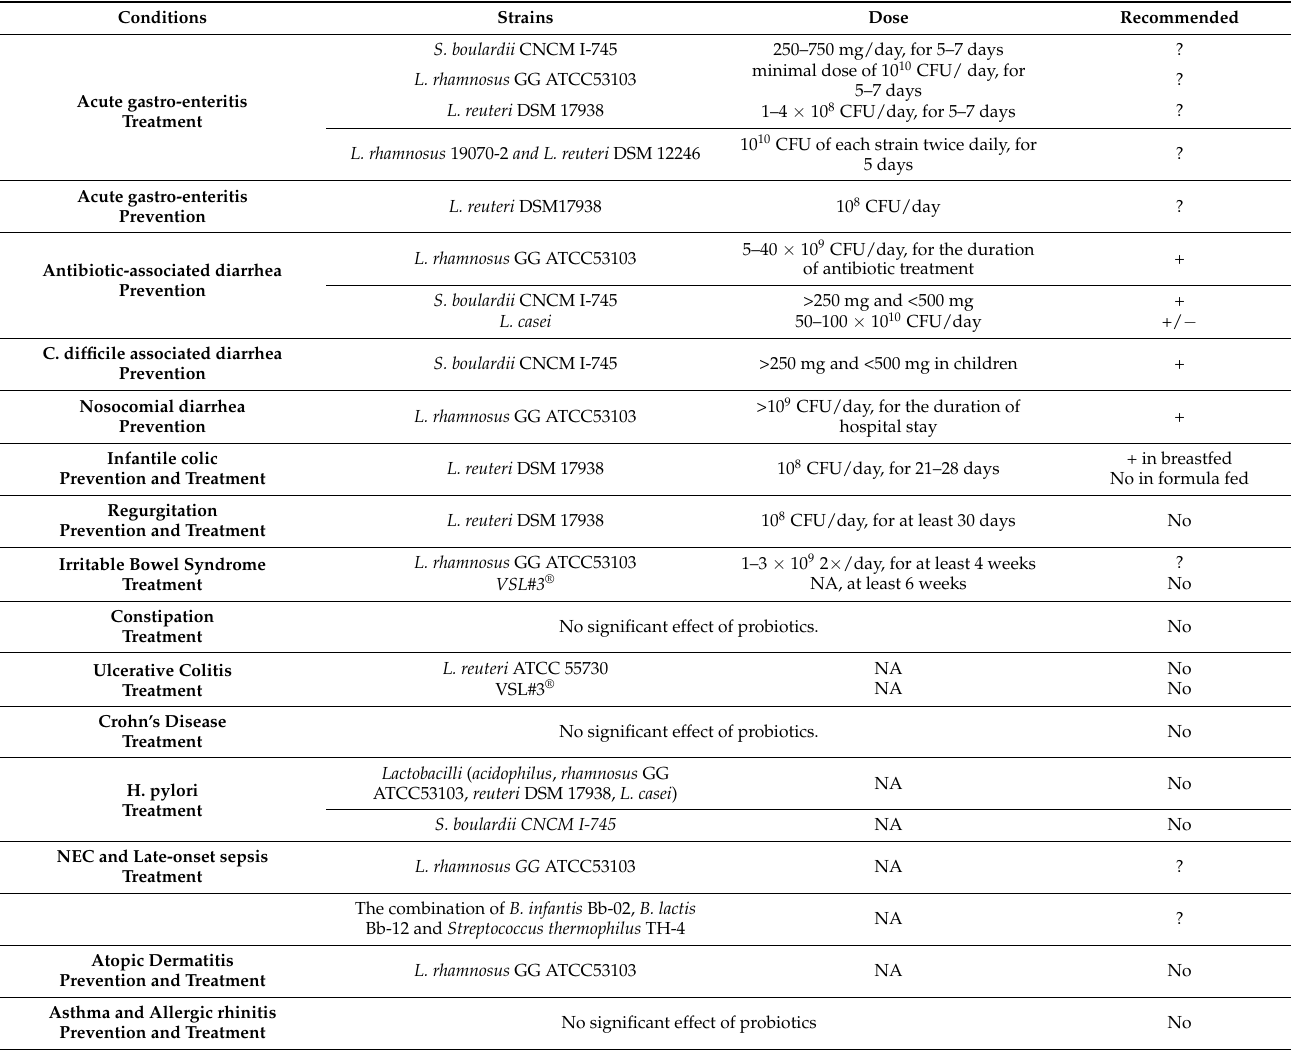
Table 16. Practical guide for pediatric use of